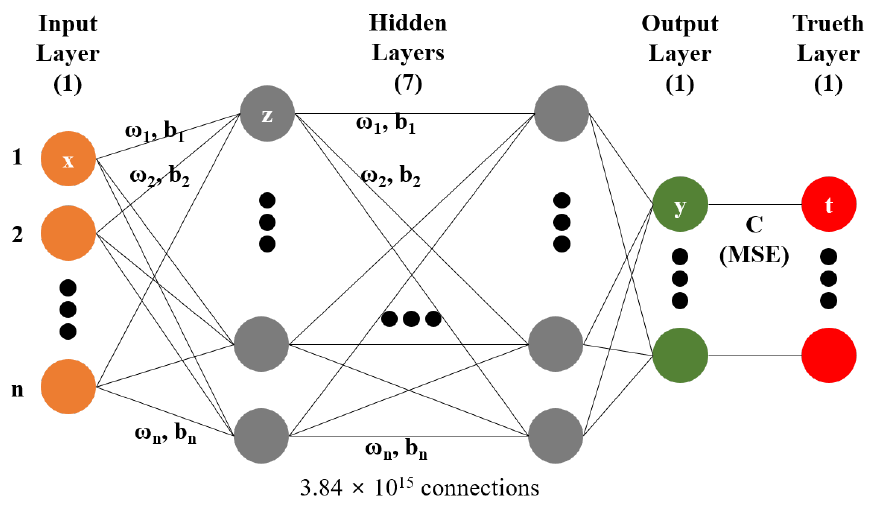
Figure 2. Schematic of fully coupled artificial neural network